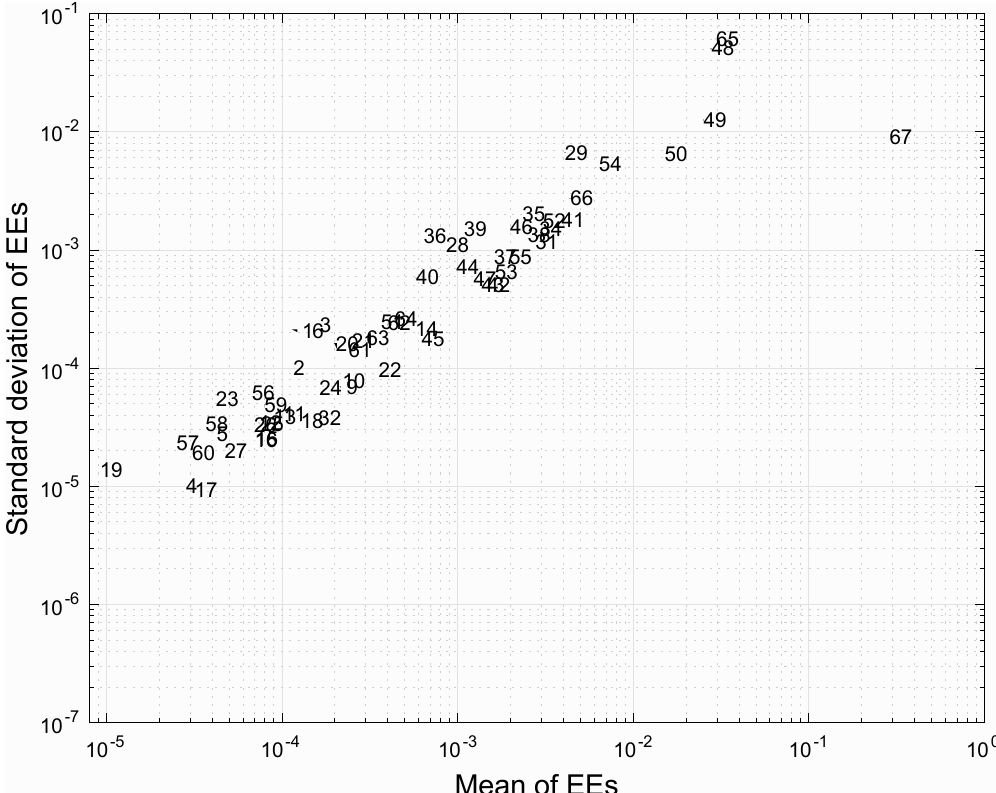
Figure 2. Global sensitivity analysis of the model output (growth rate) to a change by 40% of the 69 model parameters using the Morris method. The relative influence of each parameter on the model outcome (growth rate of F. cylindrus in the light) is quantified with a sensitivity index called “mean of elementary effect”, or mean EEs on the X-axis. The relative strength of interactions between parameters can also be visualized with the standard deviation of elementary effects (standard deviations of EEs) on the Y-axis. All points are numbered following the order of appearance of parameters in Figure 1 from left to right. Note that the parameters #7, #30, and #33 are not shown, since they have standard deviations of EEs and mean EEs smaller than 10 − 11 .